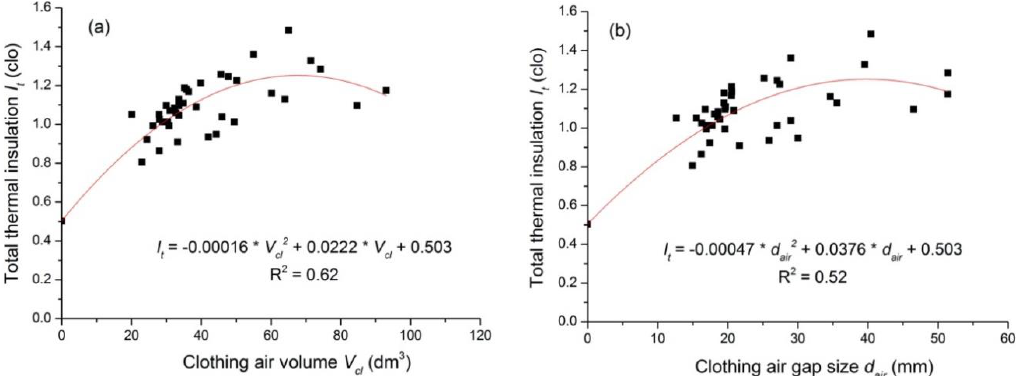
Figure 2. Relationship between the clothing total thermal insulation and ( a ) the air volume; ( b ) the air gap size.